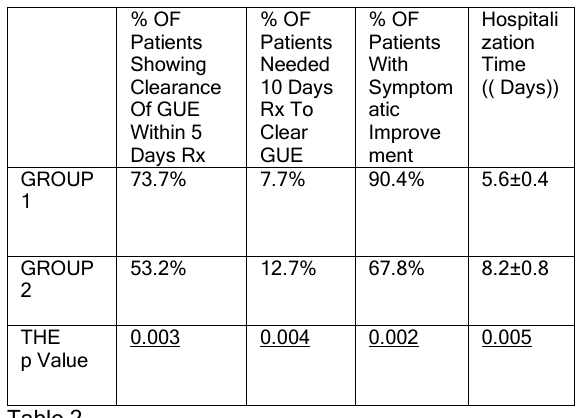
The statistics of the research depended upon the regression analysis and the extraction of:The Mean.The p_ Value to determine statistical significance.Any p_ value more than 0.05 was considered statistically insignificant Results: i. Clinical and laboratory response: 73.7% of the patients responded to treatment (monitored by clearance of general urine exam) within 5 days of treatment in group1 vs. 53.2% of patients in group 2 ((p- value=0.003)).7.7% of patients in group 1 needed 10 days of treatment to clear the GUE vs 12.7% of the patients in group 2 ((p-value=0.004)).(90.4%) of patients in group 1 showed symptomatic improvement after 5 days of treatment initiation versus (67.8%) in group 2 ((p- value=0.002)).The urine cultures were negative in ((76.4, 80.1, 85.9,95.0 percentages of patients)) after ((10 days, 1 month, 3 months and 6 months respectively)) in group1 vs. ((60.3, 68.60,75.8,85.3 )) after the same periods in group 2 ((p-value=0.04 at 10 days, 0.03 at 1month, 0.04 at 3 month and 0.02 at